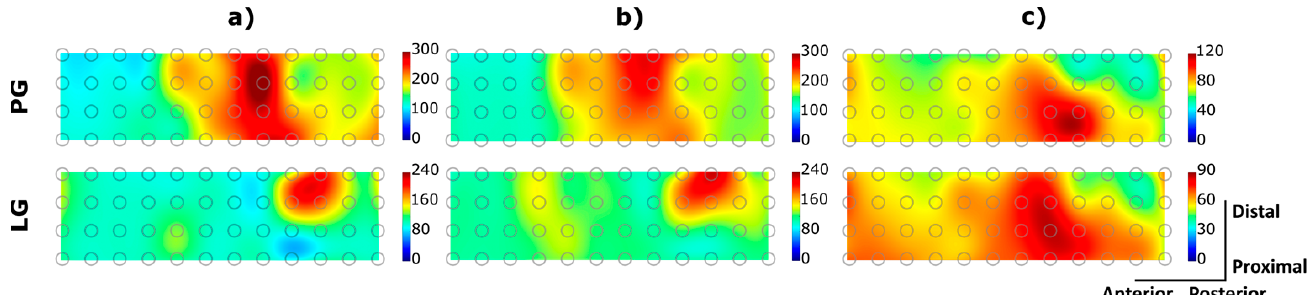
Figure 9. Spatial pattern of muscle activity recorded from a representative able-bodied participant wearing the ( a ) PET and ( b ) TEX interface and ( c ) the amputee subject wearing the TEX interface. The correlation coefficients calculated between PET and TEX for the PG maps and LG maps of the able-bodied participant were 0.88 and 0.92, respectively. The units for the colour scale are µV. (PG: power grasp, LG: lateral grasp).